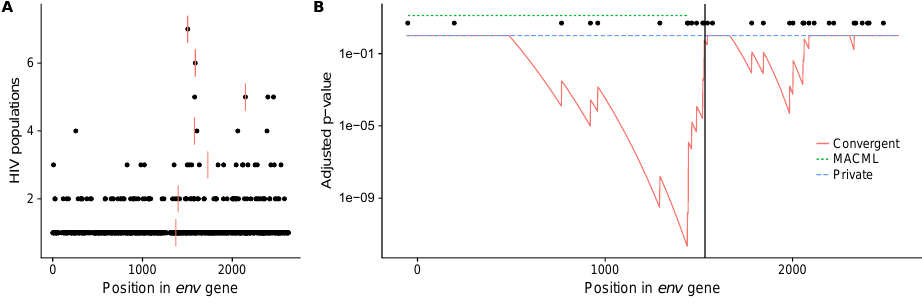
Figure 2. Convergent mutations are predominantly located in gp41. (A) Shows the positions of mutations across the env gene on the x-axis and the number of HIV-1 populations the mutations were observed in on the y-axis. Red bars indicate the mean of all positions of the mutations that occur in the same number of HIV-1 populations. (B) Shows whether there is a significant difference (adjusted p-value on y-axis) in the distribution of mutations before a certain position in the env gene compared to after this position. There is no significant signal for the distribution of private mutations (blue line). The red line shows the adjusted p-values for the distribution of mutations that occur in at least three HIV populations in parallel. The lowest p-value is found at nucleotide position 1438 in the env gene (position 7663 in HXB2, 479 in the env protein). For convergent mutations, a low mutation density region was identified by MACML (Zhang, Townsend 2009) and is indicated in green. The end of this region is also the minimum of the adjusted mutation distribution p-value from above. The black vertical line indicates the start of the Gp41 protein, a fusion protein that is part of the env gene. Black dots above the blue line indicate the positions of mutations that occur in three or more HIV-1